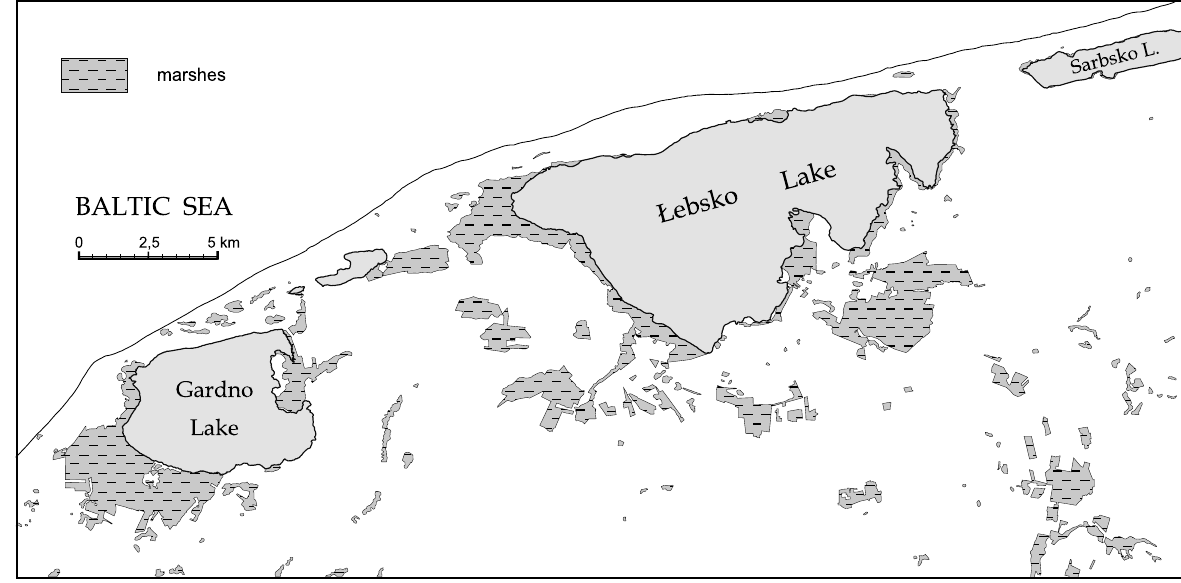
Fig. 5. Extent of wetlands in the Gardno-Łeba Lowland in the early 20th